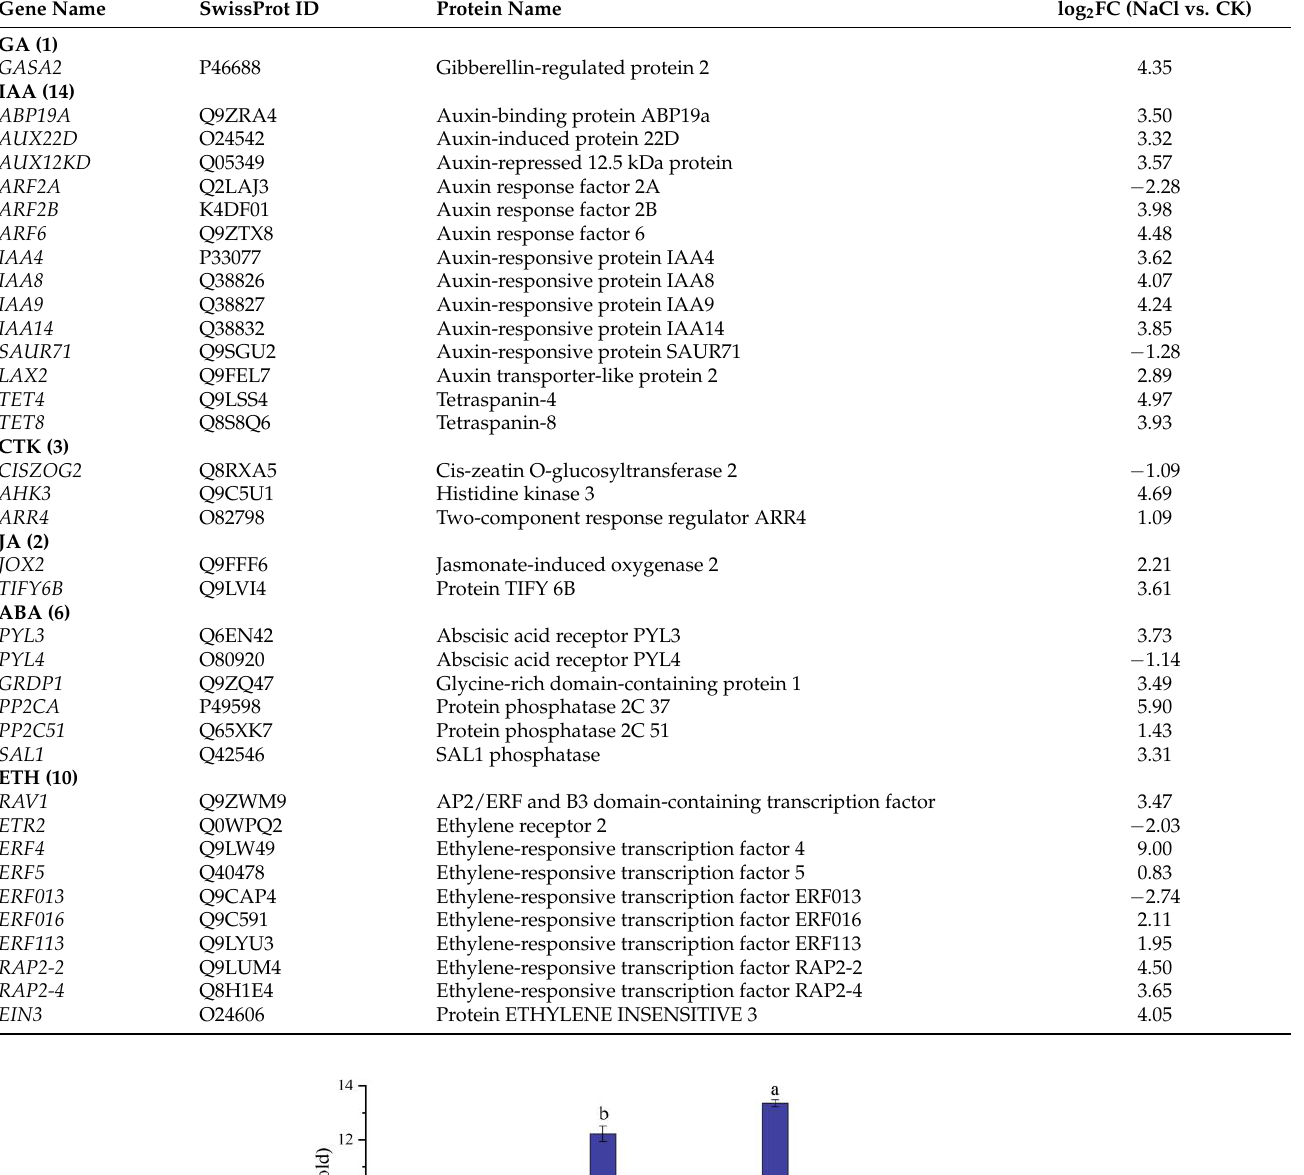
Table 7. Thirty-six DEGs directly associated with hormone response at 300 mmol/L NaCl vs. CK.